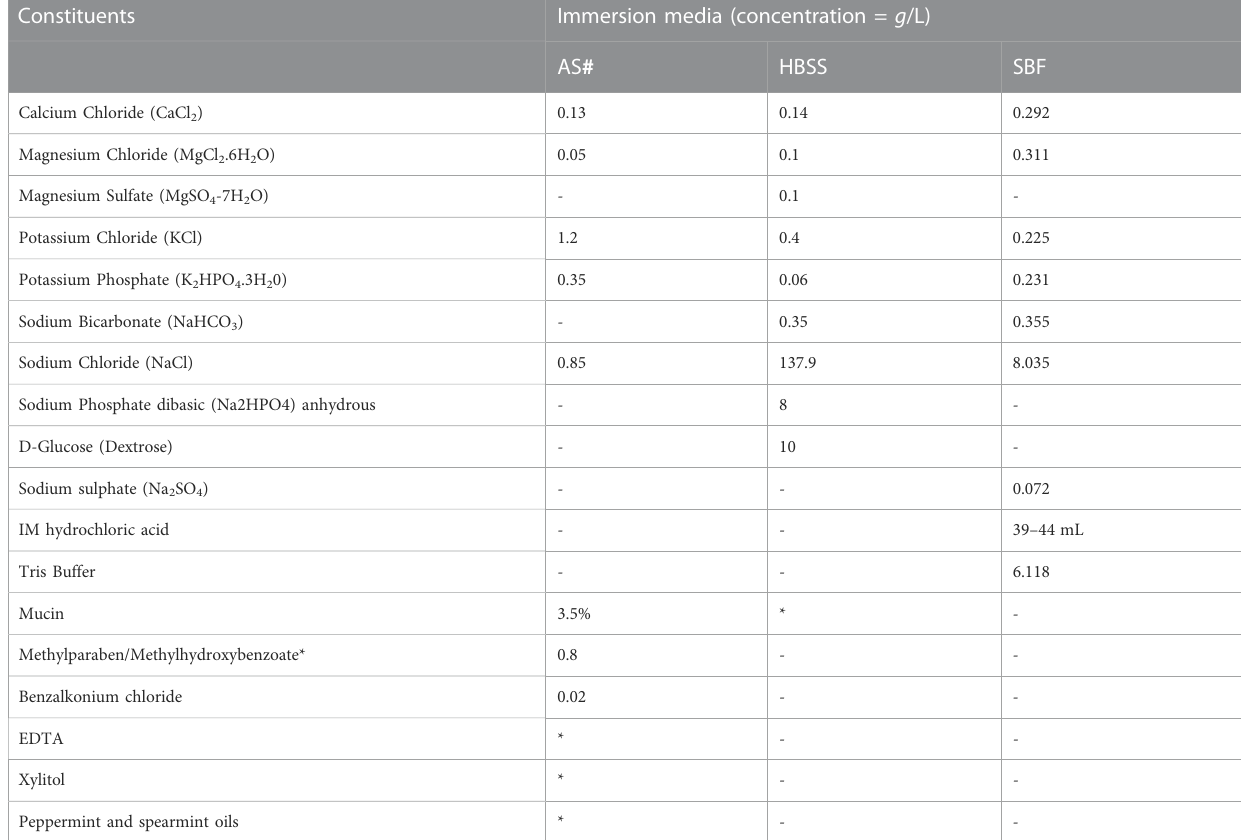
TABLE 1 Overview of the composition of the three immersion media used in the